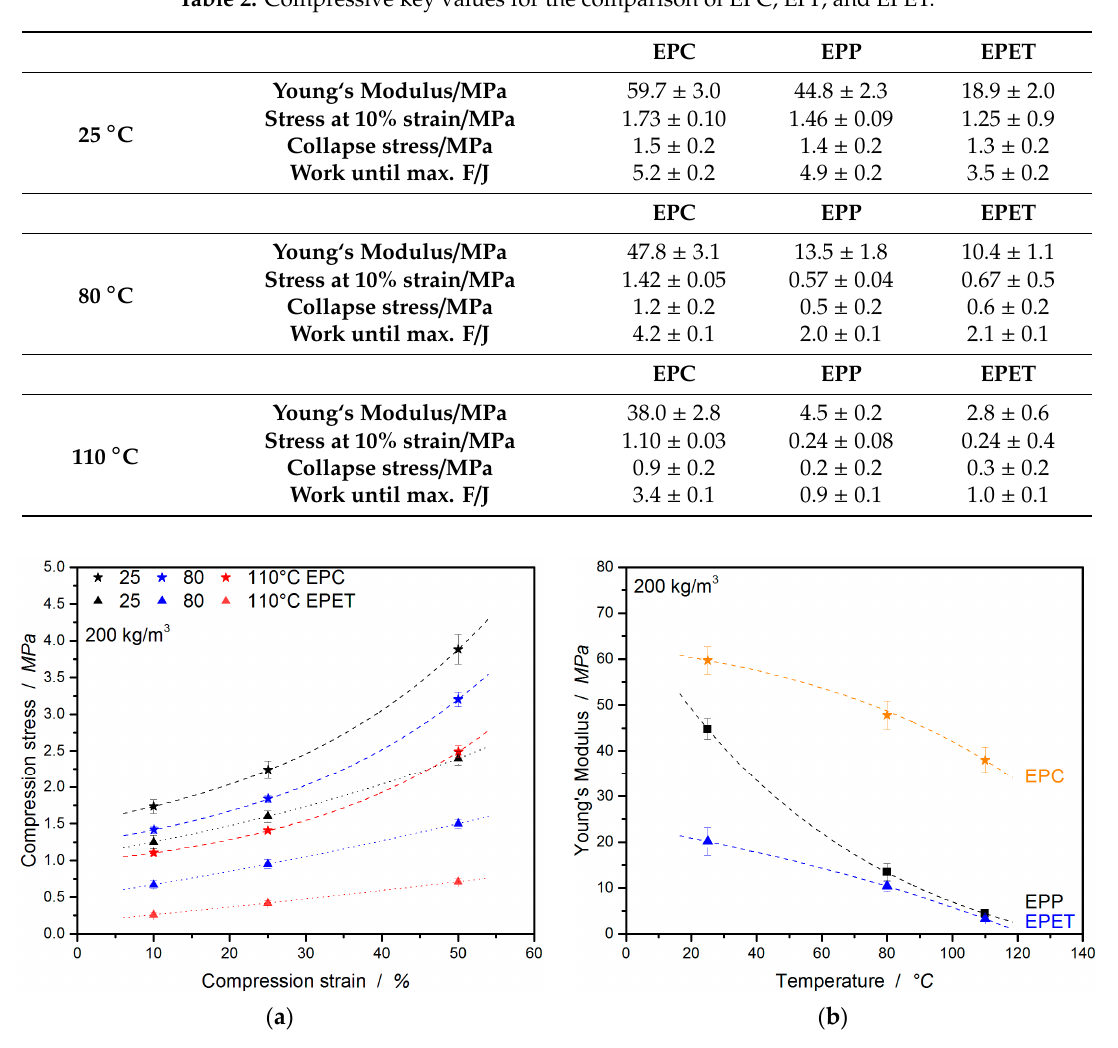
Figure 6. Comparison of compression strength ( a ) and compression moduli ( b ) of EPC to EPET at 25, 80, and 110 ◦